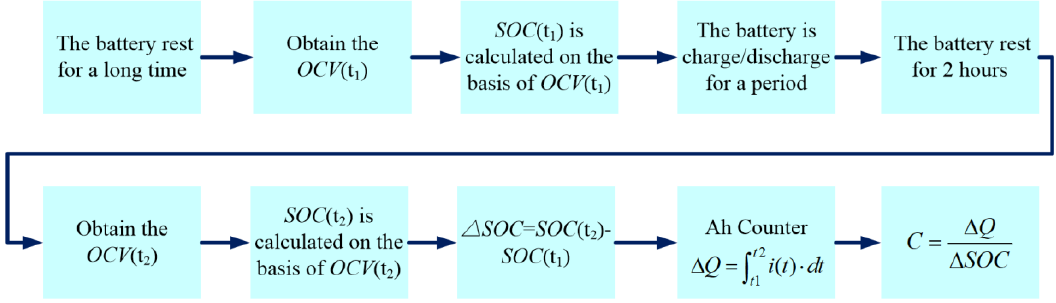
Figure 12. Flowchart of the capacity estimation based on OCV.